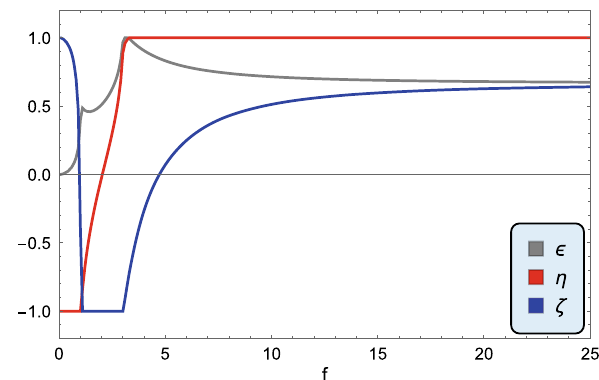
Fig. 2 n s versus r plots compared with Planck 2015 results [61] for TT, TE, EE + lowP, at the 95% CL and 68% CL